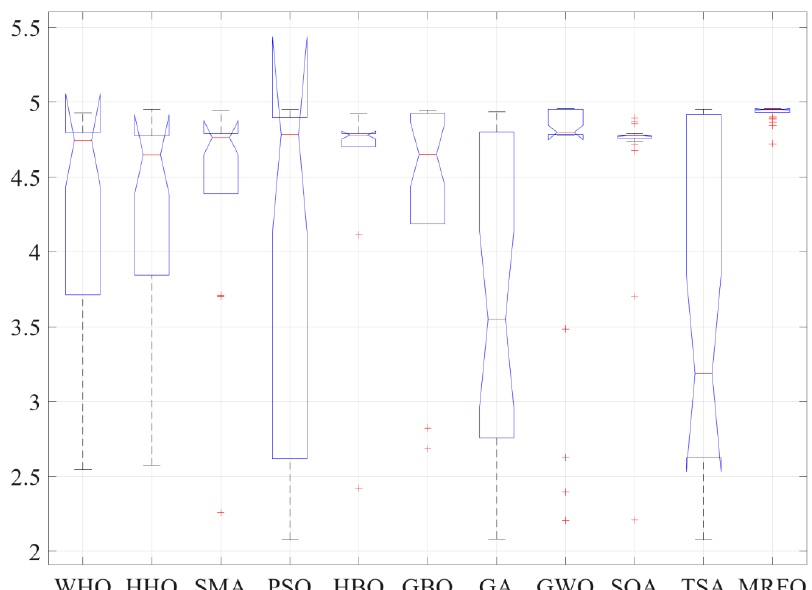
Figure 7. Observations through the independent runs based on ANOVA test.